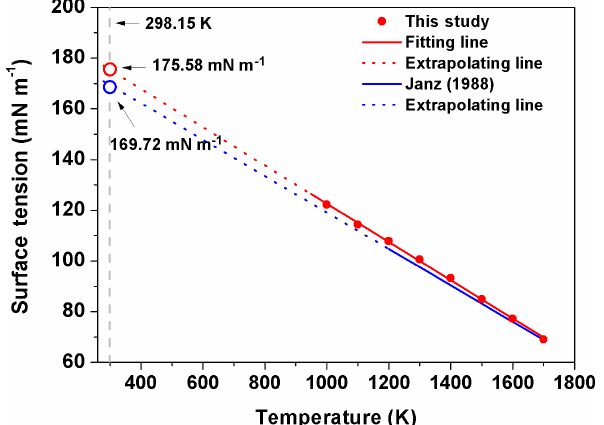
Figure 5. The surface tension of molten NaCl at different tempera- tures. The equation in Janz’s study (1988) is σ NaCl = − 0 . 07188 · T + 191 (blue solid line). The fitting line based on our data is σ NaCl = − 0 . 0755 · T + 198 . 09 (red solid line). The red and blue open circles represent the extrapolated value of surface tension in simulation and reality, respectively.